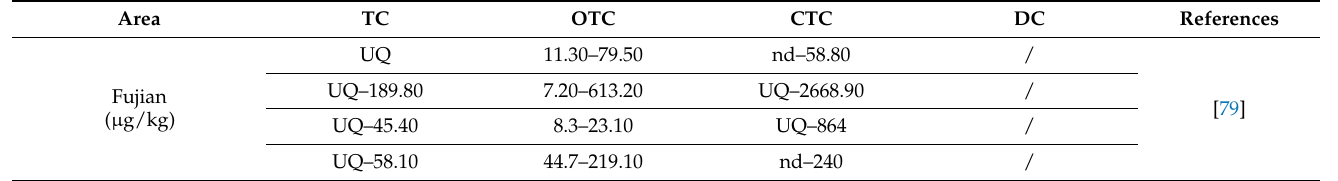
Table 3. TCs’ residual content in